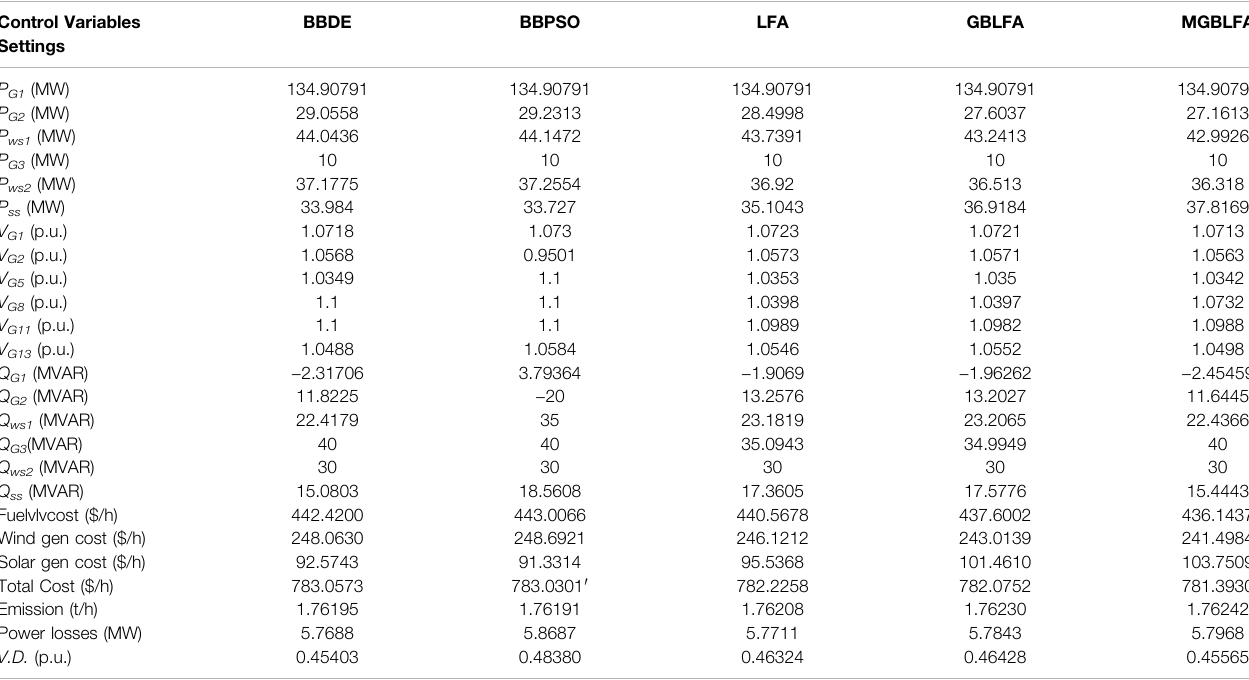
TABLE 11 | The variables optimal values obtained by algorithms for Case 9. Control Variables